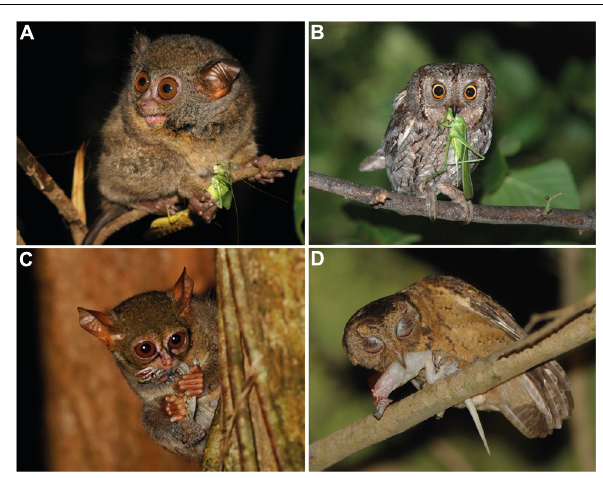
FIGURE 2 | (A) Orthopteran insects such as katydids are a common prey item in the diet of tarsiers (photograph of Tarsius lariang by Stefan Merker, reproduced with permission). (B) Orthopteran insects are also consumed by scops owls (photograph of Otus scops by Clément and Julien Pappalardo, reproduced with permission). (C) Tarsiers also consume geckos (photograph of T. spectrum by David J. Slater, reproduced with permission). (D) In Singapore, geckos are reported to be the most common food item in the diet of O. lempiji (Lok etal., 2009; photograph byTiah Khee Lee, reproduced with